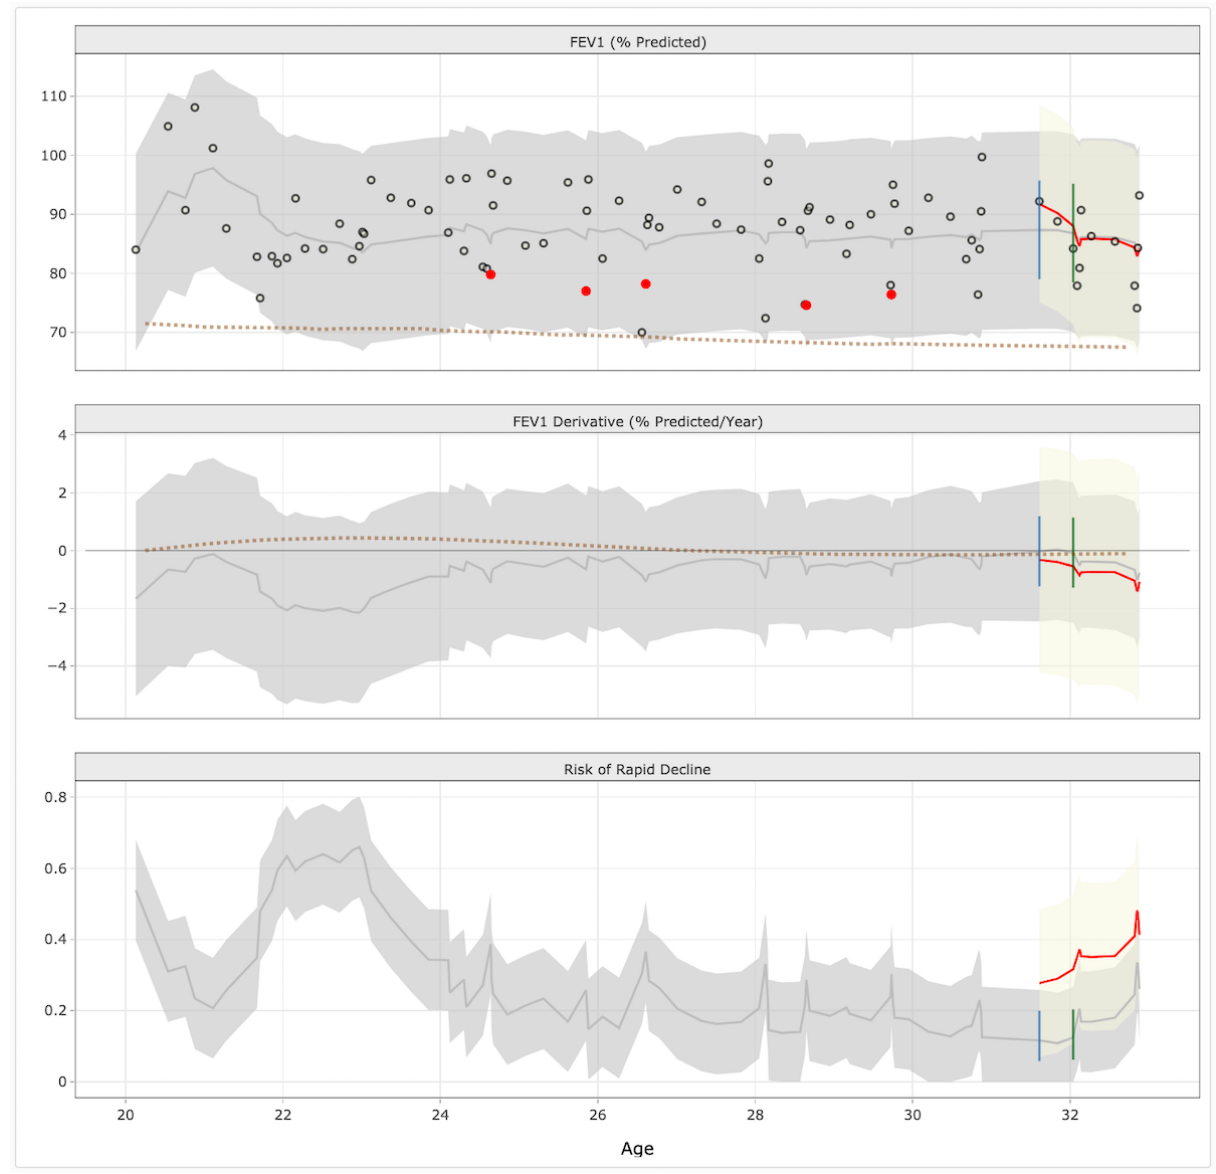
Figure 3. Middle panel of Cystic Fibrosis Point of Personalized Detection (CFPOPD). The 3 plots show pulmonary function data from patient 341. The top plot displays the patient’s % predicted forced expiratory volume in 1 second (FEV1) values (circles) recorded during pulmonary function testing, as well as the patient’s fitted (gray line) and forecasted (red line) values. Pulmonary function values recorded at the time a patient experienced a pulmonary exacerbation are colored red. A dotted line shows normative data (dynamic medians) respective to the patients % predicted values and rate of change in FEV1 (middle plot). The plot shows that the patient’s rate of change in FEV1 fluctuated initially but has remained stable from ages 24 to 32 years. Compared to the overall norms, patient 341’s rate of change is analogous to other patients. Similarly, the patient’s risk of rapid decline initially fluctuated but declined and stabilized (bottom plot). All plots show that patient 341 was prescribed a modulator at 31 years of age (blue line; ivacaftor) and a second modulator at 32 years of age (green line;